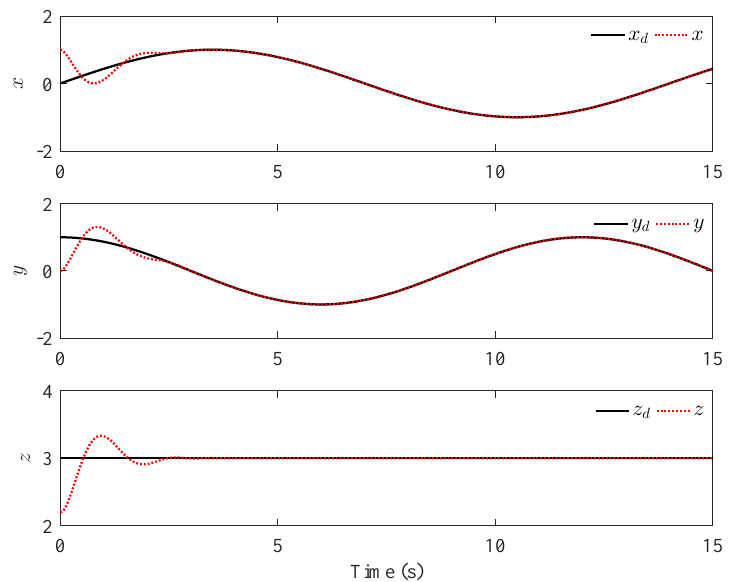
Figure 2. The tracking curves of the position